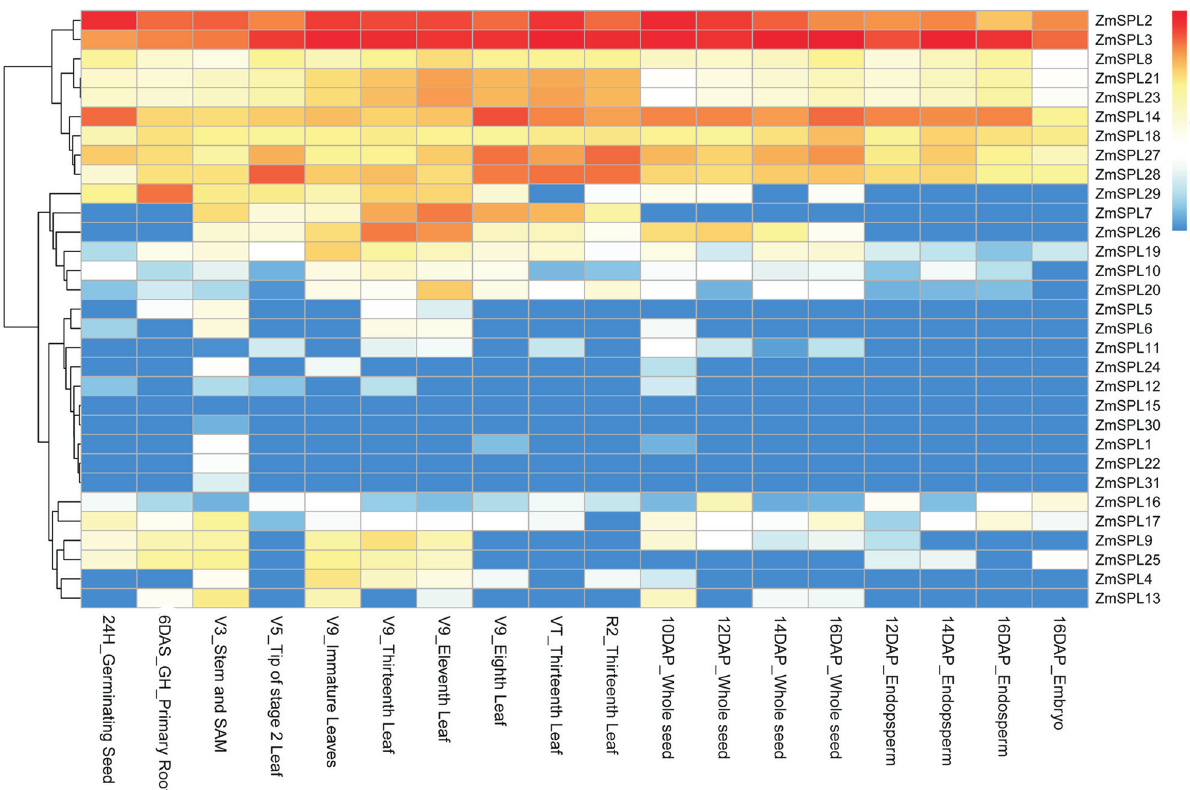
Figure 7 - Expression profiles of ZmSPLs at different developmental stages. Blue and red indicate low and high levels of transcript abundance, respec- tively. Tissues from different developmental stages are shown at the bottom of the heat